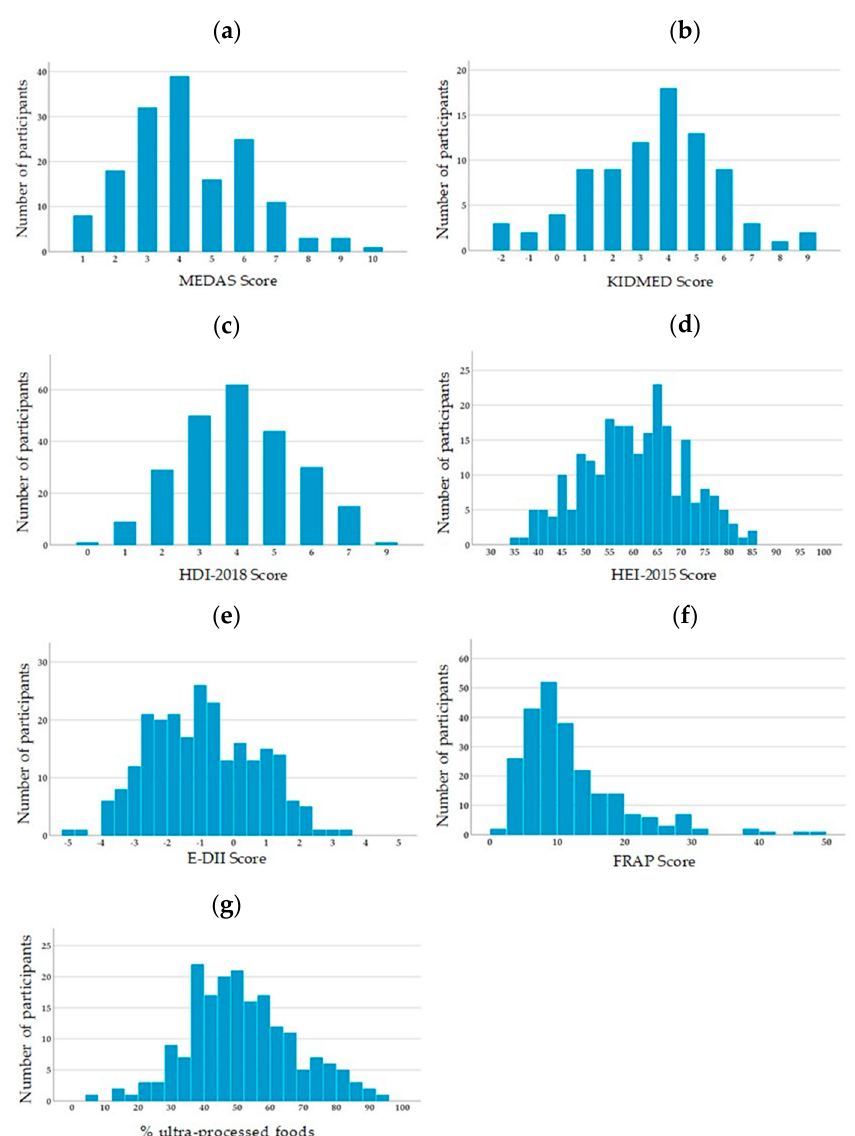
Figure 1. Distribution of the dietary scores among participants. ( a ) MEDAS (Mediterranean Diet Adherence Screener) score; ( b ) KIDMED (Mediterranean Diet Quality Index for children and adolescents) score; ( c ) HDI (Healthy Diet Indicator)-2018 score; ( d ) HEI (Healthy Eating Index)-2015 score; ( e ) E-DII (Energy-adjusted dietary Inflammatory Index) score; ( f ) FRAP (Ferric reducing ability of plasma) score; ( g ) contribution of ultra-processed foods according to the NOVA classification.